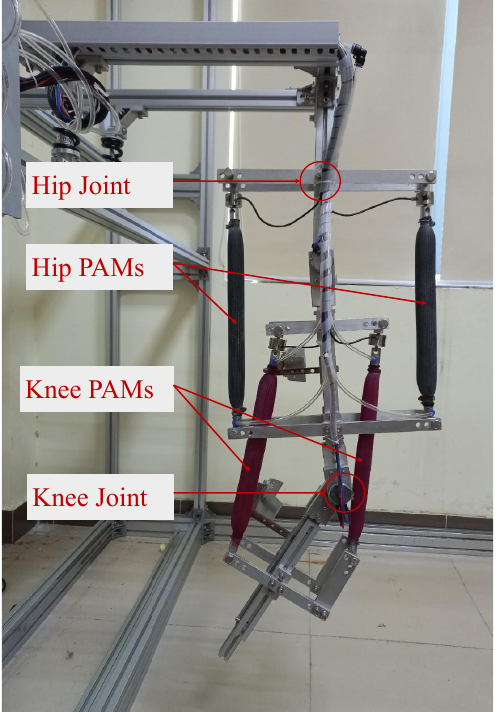
Figure 1. The lower-limb exoskeleton of the BK-gait rehabilitation system. Each robot joint (hip or knee) was actuated by two opposing pneumatic